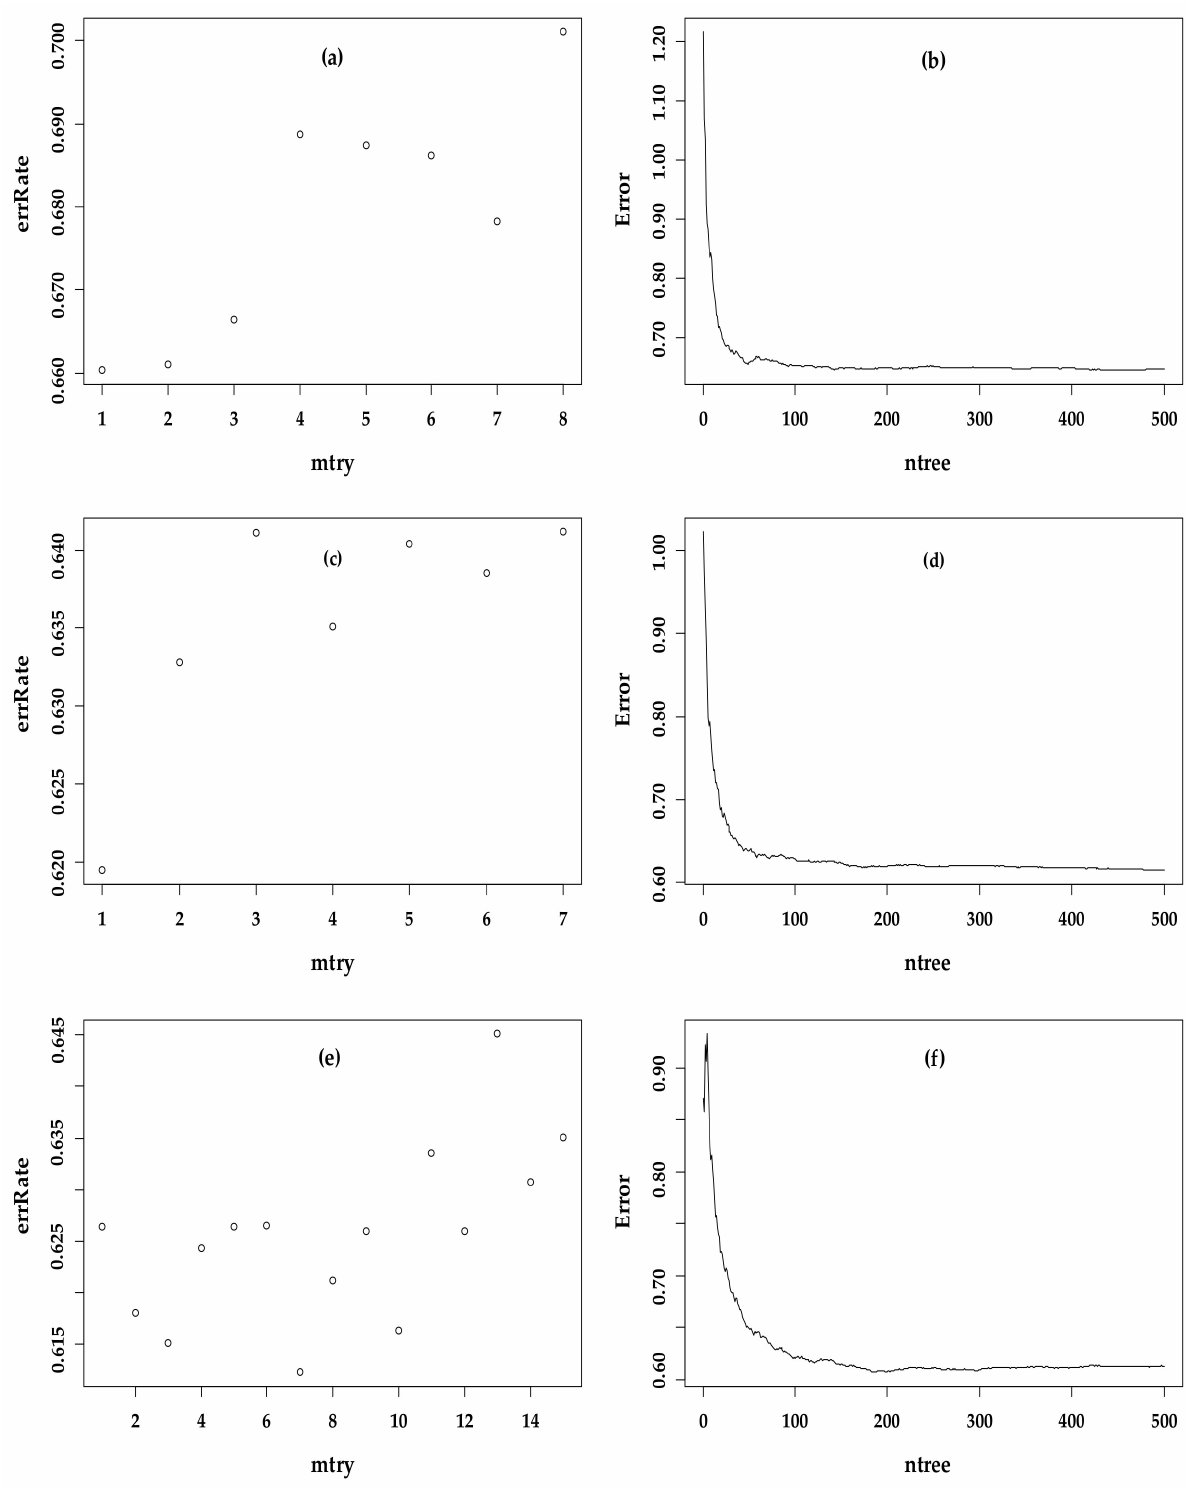
Figure 7. ( a , c , e ) are the distribution of error rate versus mtry; ( b , d , f ) are the distribution of the error versus ntree; ( a , b ) are related to the BBM; ( c , d ) are related to the VBM; and ( e , f ) are related to the